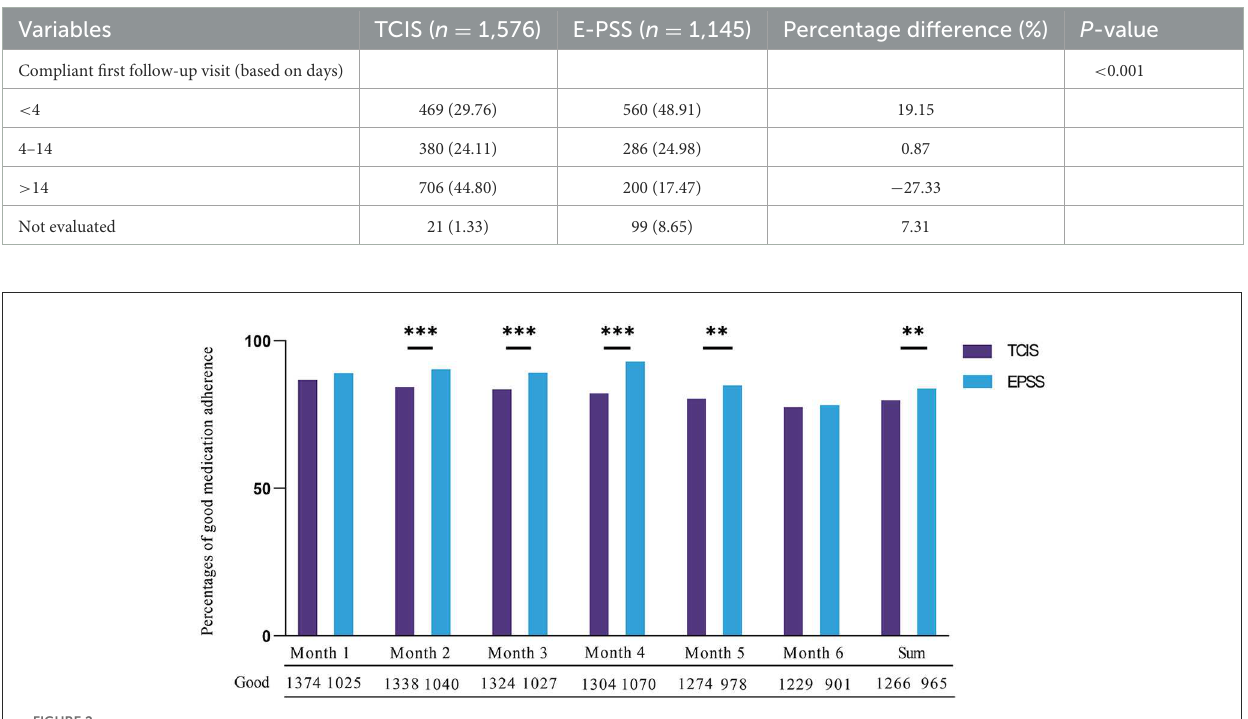
FIGURE2 Medication adherence recorded in TCIS and e-PSS for 6 months. Good medication adherence defined as more than 80% of prescribed monthly doses taken. ** P < 0.01. *** P < 0.001. All the bar graphs were grouped by month; the bar graph on the left in each group depicted the data distribution of good medication adherence in TCIS, and the number of good medication adherence was denoted by the digit under each column. Conversely, the bar graph on the right depicted that in e-PSS.